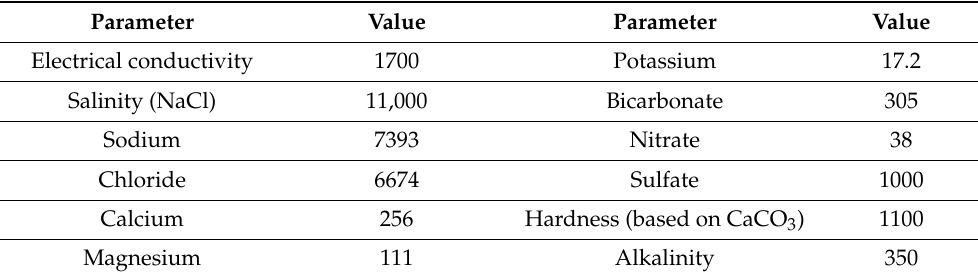
Table 1. Groundwater quality parameters.